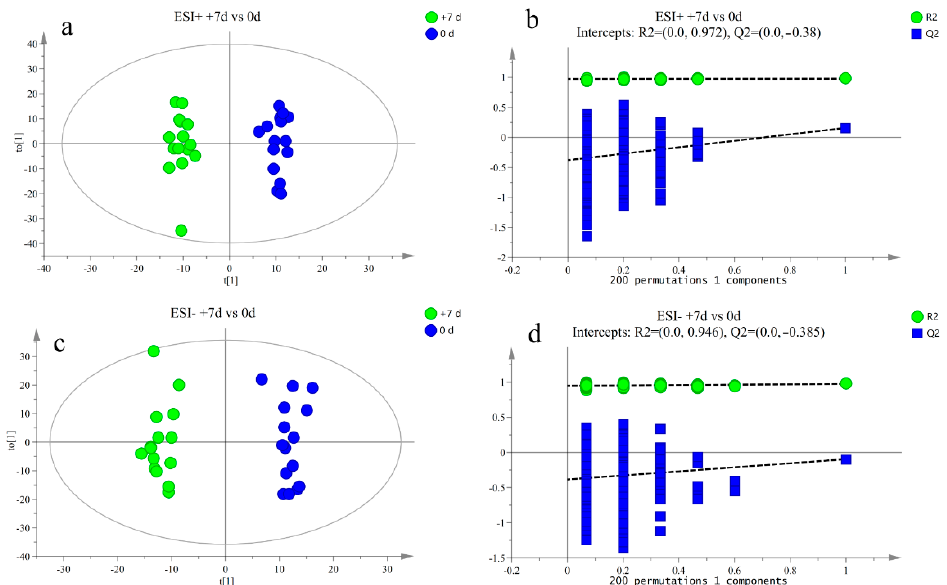
Figure 4. ( a , b ) Orthogonal partial least squares discriminant analysis (OPLS-DA) of scores and permutation test plots for the +7 d and 0 d group samples analyzed in the positive ion mode, respectively. ( c , d ) Orthogonal partial least squares discriminant analysis of scores and permutation test plots for the +7 d and 0 d group samples analyzed in the negative ion mode, respectively. t[1]—first principal component; to [1]—second orthogonal component. The intercept limit of Q 2 , calculated by regression line, is the plot of Q 2 from permutation test in the OPLS-DA model.